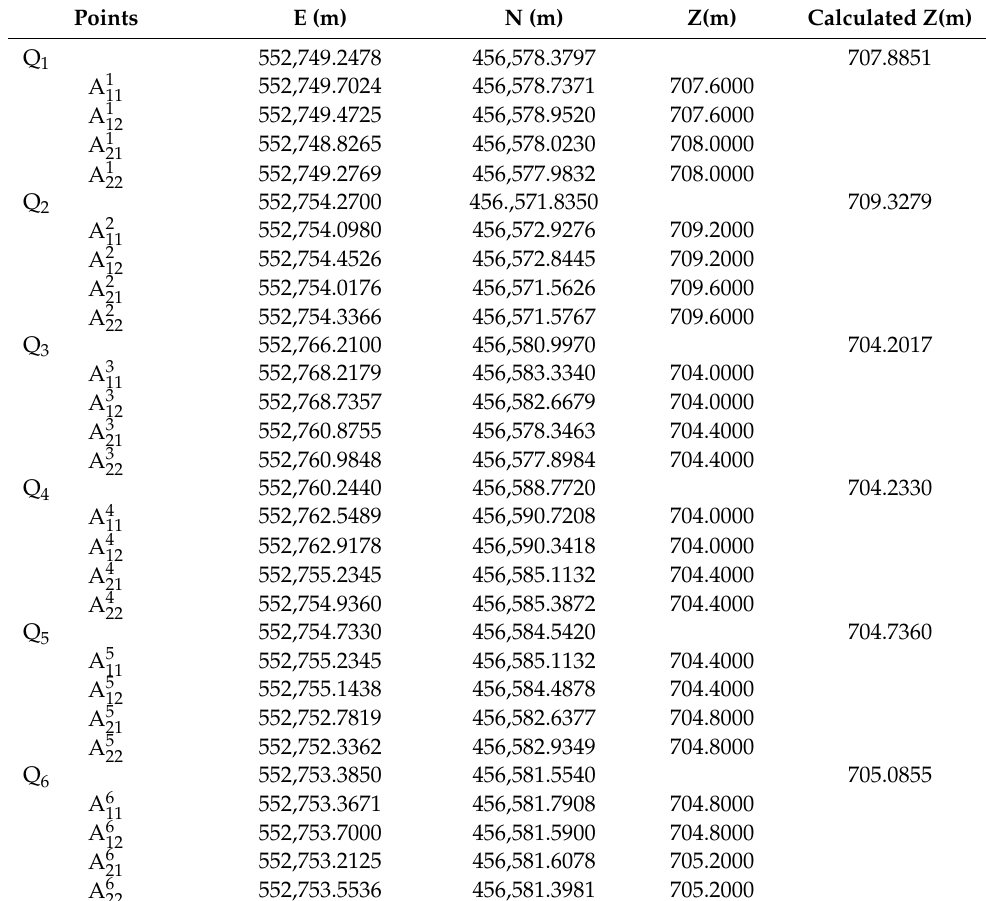
Table 2. 3D coordinates of the Q points.